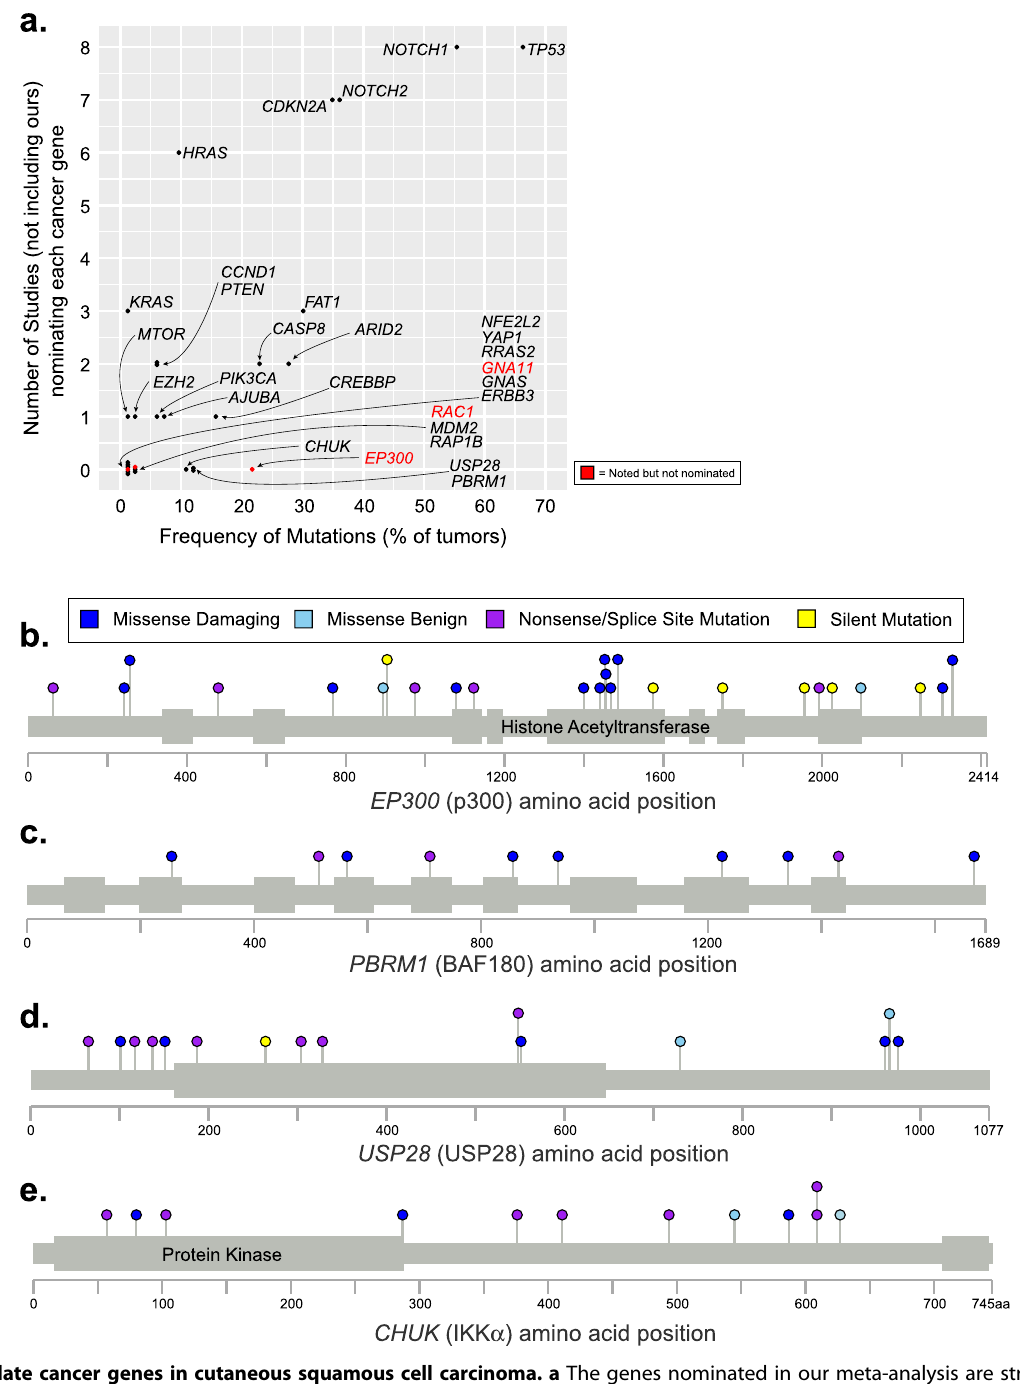
Fig. 3 Candidate cancer genes in cutaneous squamous cell carcinoma. a The genes nominated in our meta-analysis are strati fi ed by their mutation frequency ( x -axis) and how often they were nominated in eight previous studies ( y -axis) that cataloged drivers of cutaneous squamous cell carcinoma. We further inspected the genes nominated by us, but not others (those with a value of 0 on the y -axis). Some were borderline signi fi cant in other studies, which we designate in red text (see “ Methods ” for more details on the difference between “ nominated